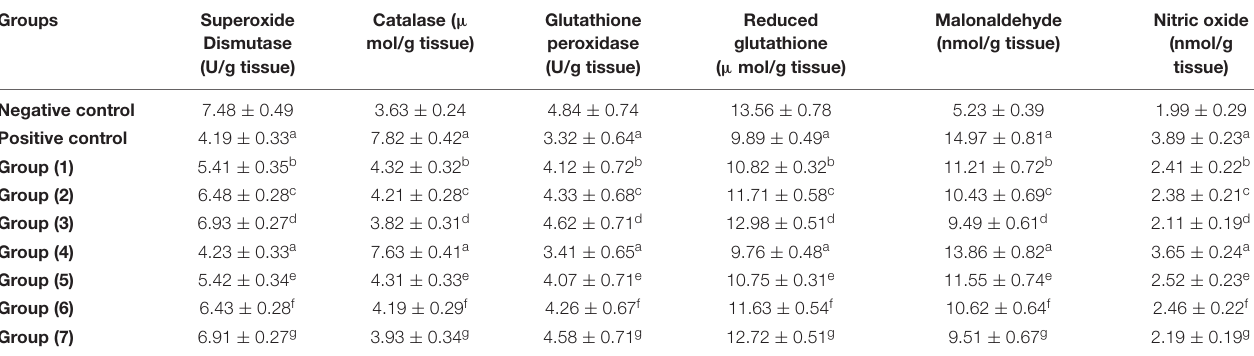
TABLE 7 | Effects of the RB, BR, and SL complex coacervates and UF cheese with complex coacervates on biochemical parameters.